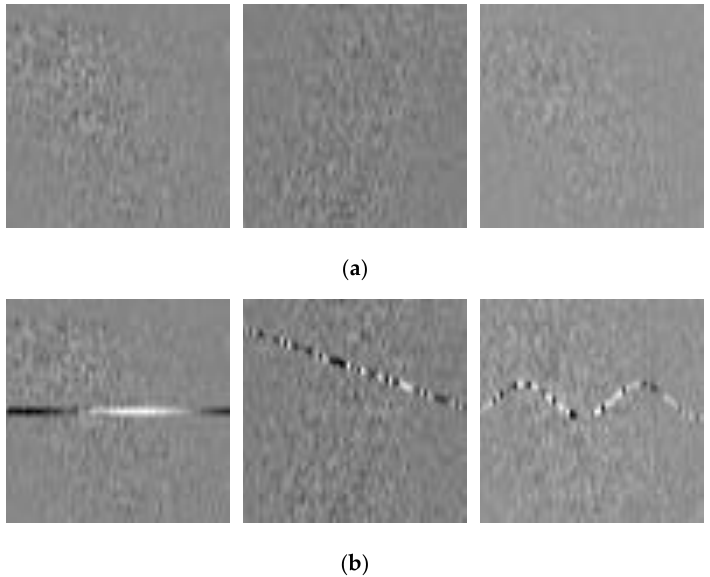
Figure 7. Simulated SAR echoes in the time–frequency domain for training and testing the IMN. ( a ) the original SAR echoes without interference, and ( b ) the interference-corrupted echoes.